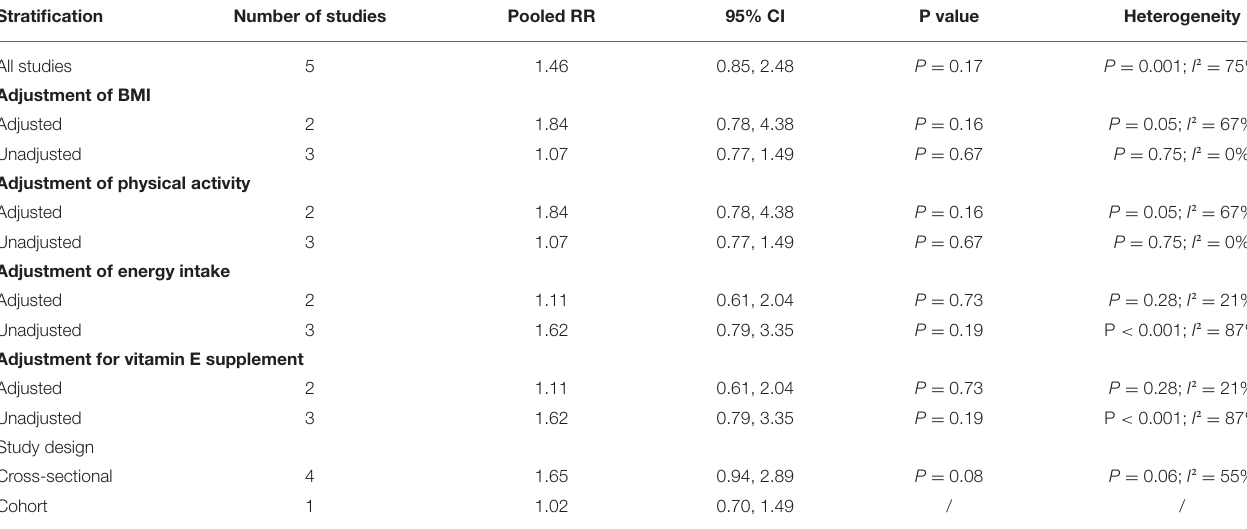
TABLE 4 | Subgroup analysis of MetS for the highest vs. lowest circulating vitamin E level